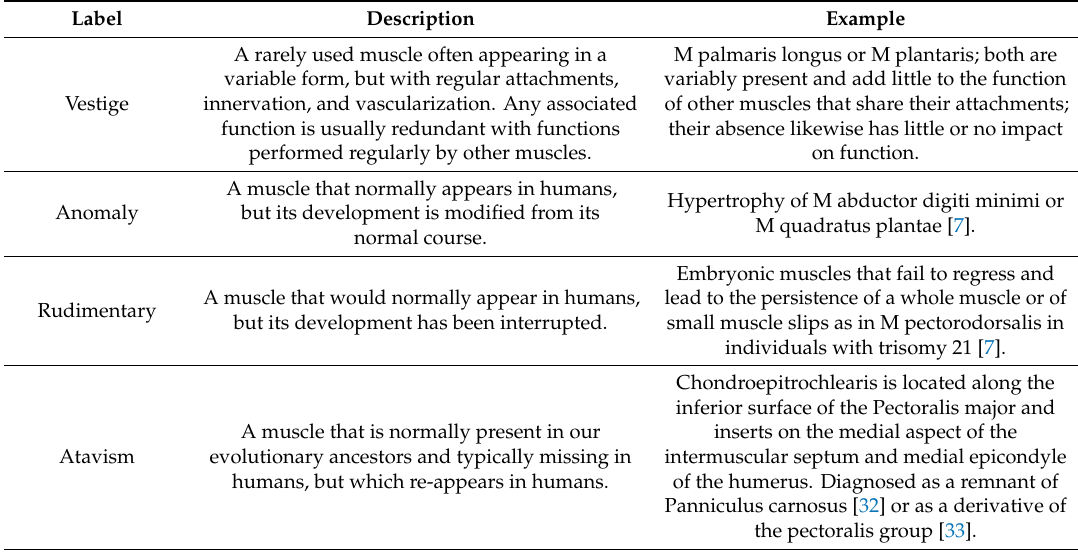
Table 1. Explanations for skeletal muscle variants.